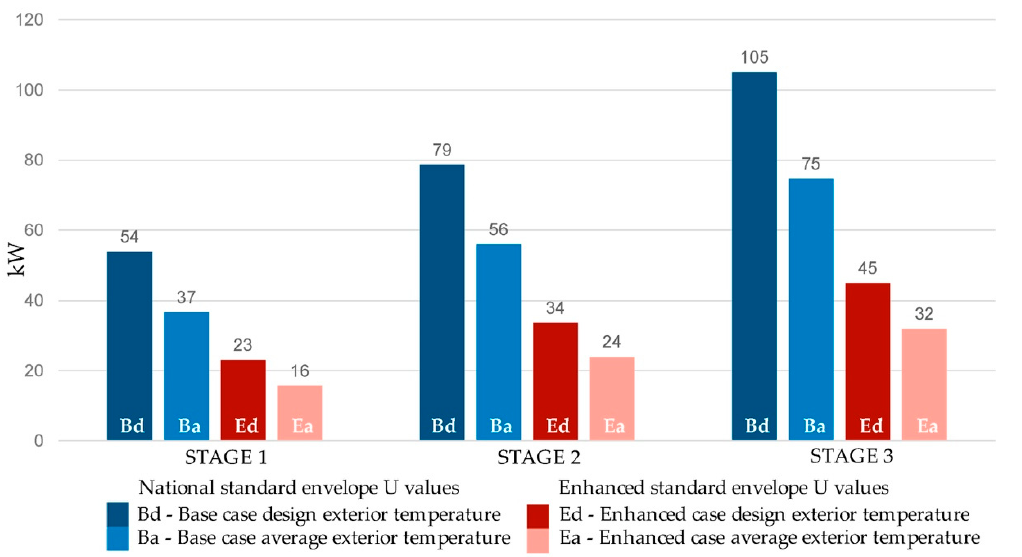
Figure 13. Energy needed for heating.